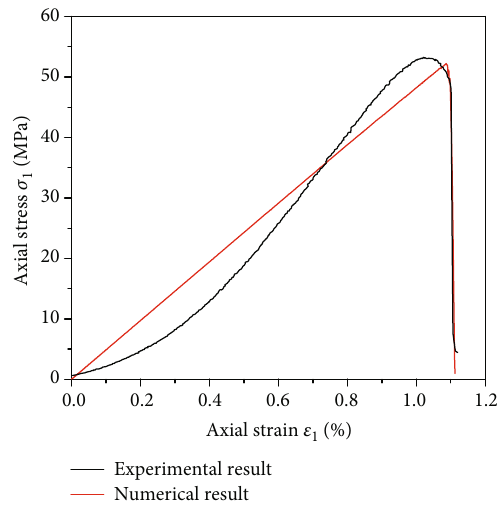
Figure 5: The comparison between the numerical and experimental stress-strain curves of intact sandstone